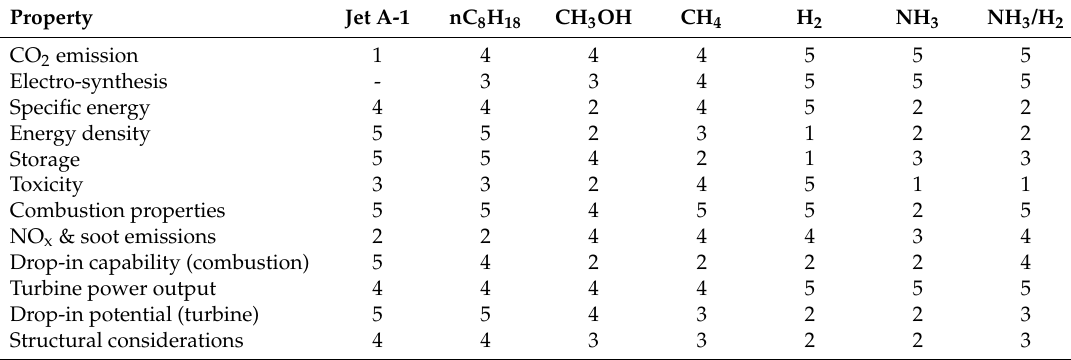
Table 8. Evaluation matrix for the selected electrofuels in this study (excellent: 5, good: 4, satisfactory: 3, challenging: 2, problematic: